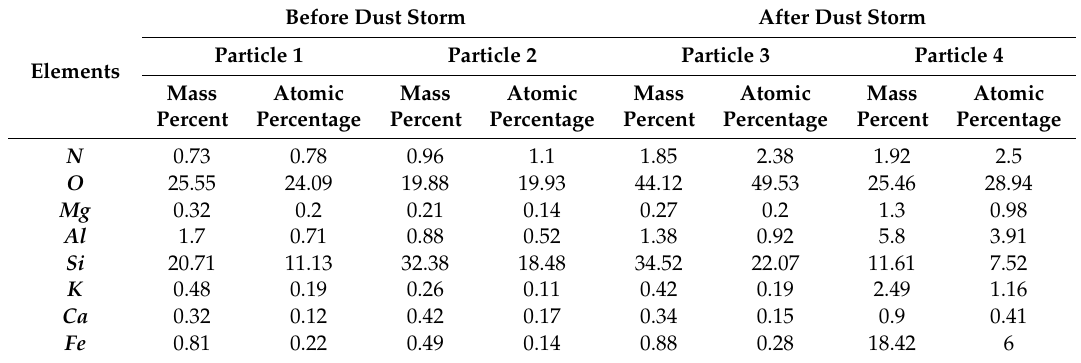
Table 1. Element content of four PM 10 particles on Pinus tabulaeformis leaf surfaces before and after dust storm